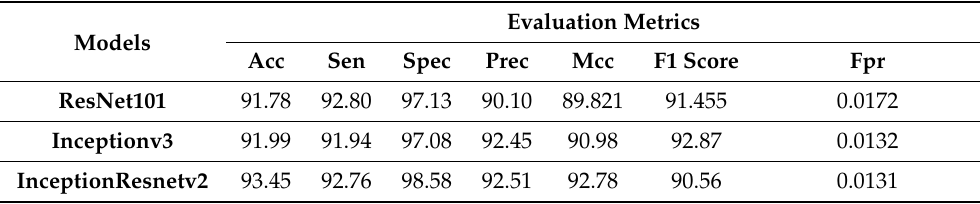
Evaluation Metrics